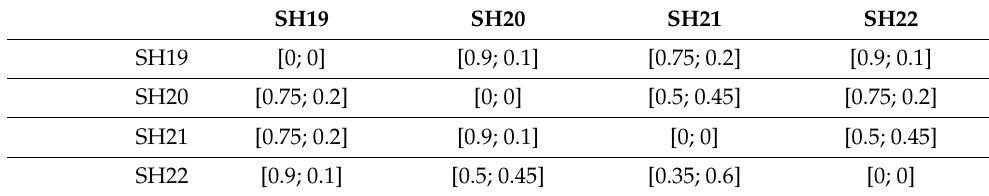
Table 5. Initial intuitionistic fuzzy matrix—Expert 1 (human talent sub-criteria). SH19